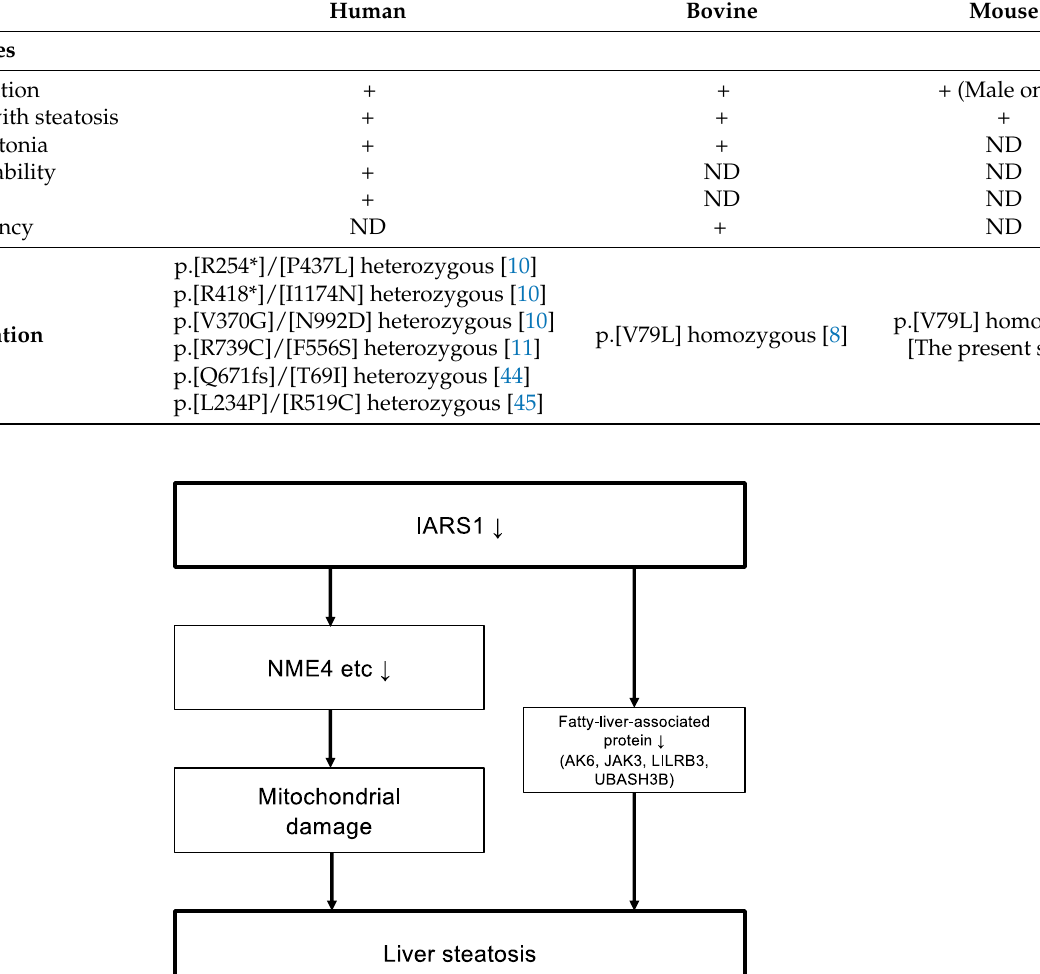
Table 2. Comparison of three species in IARS disorder. Three species demonstrating clinical symp- toms resulting from IARS mutations and sites of IARS mutations are indicated. ND is an abbreviation denoting the absence of detected clinical findings in the species. An asterisk (*) indicates an introduced stop codon; fs indicates a frame shift.